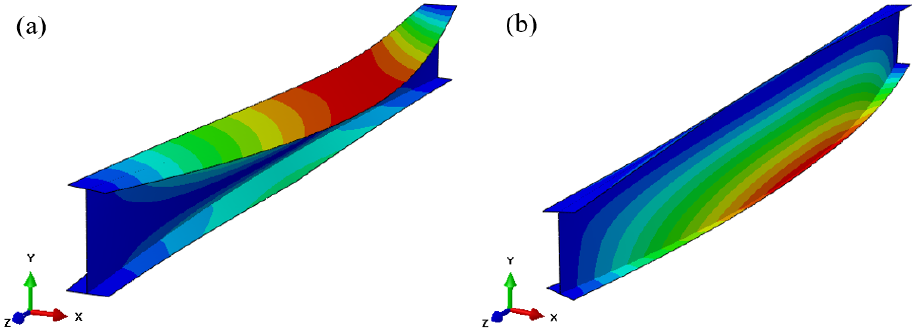
Figure 6. Typical buckling mode shapes. ( a ) M q(P) /M 1 > 1. ( b ) M q(P) /M 1 ≤ 1.